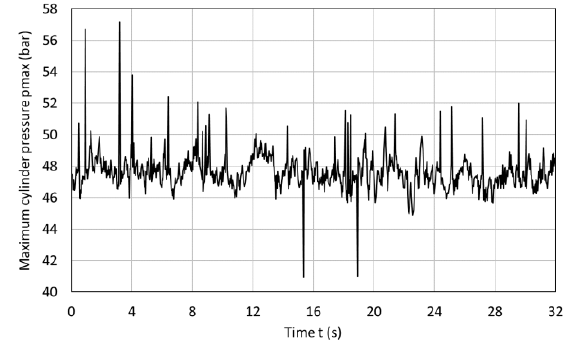
Fig. 10. Maximum cylinder pressure for operating point No. 3 Further increase in the load resulted in the occurrence of single high pressure increases. For example, the average value of p for this case was 47.64 bar, and the maximum max jump was 57.19 bar. The value of the maximum pressure in the cylinder changed in the range of 40.95–57.19 bar.